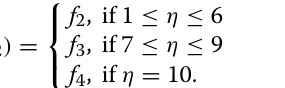
of frequency paths from ( t 0 , f 0 ) to ( t 4 , f 5 ) , we add all the frequency paths from ( t 1 , f 1 ) , ( t 1 , f 2 ) , ( t 1 , f 3 ) , and ( t 1 , f 4 )